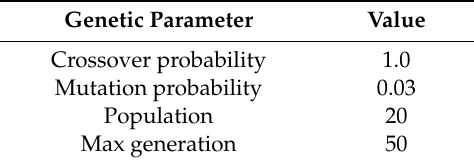
Table 3. Genetic parameters values used in the experiments.